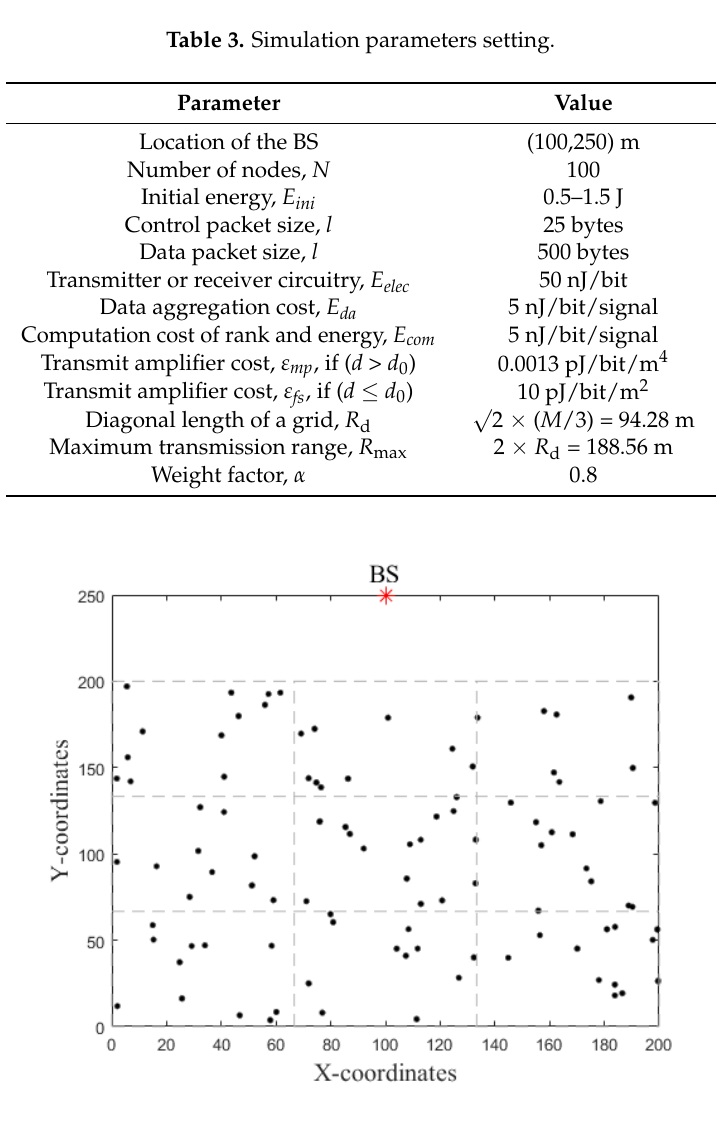
Figure 2. Example topology of the network.